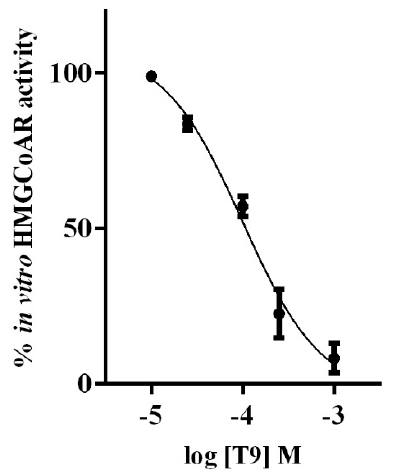
Figure 1. In vitro inhibitory effect of T9 on HMGCoAR activity.